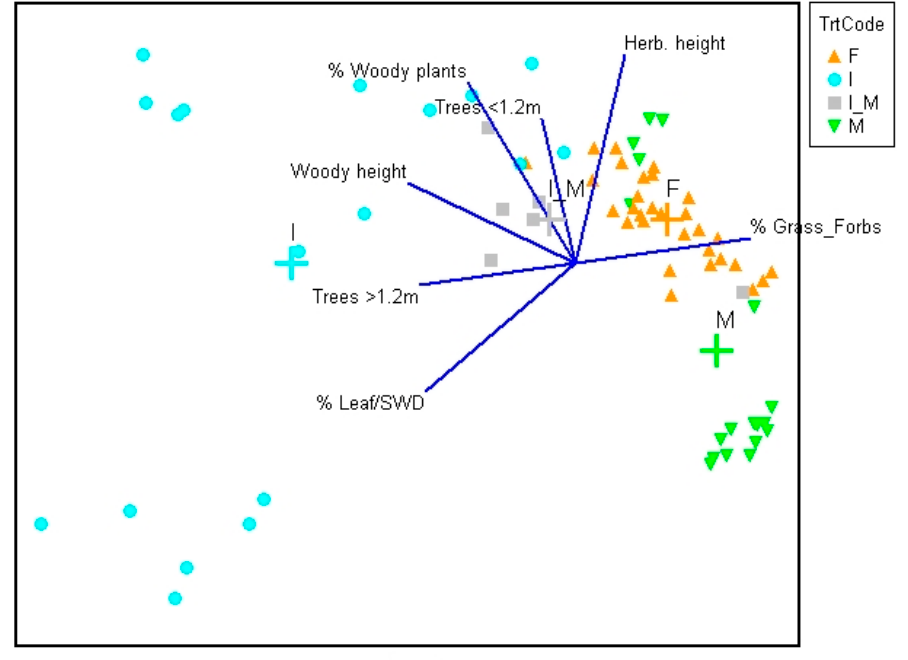
Figure 3. Principal components analysis (PCA) ordination of vegetation characteristics averaged within transects, or in the case of trees, counted along transects. Small symbols represent transects, crosses indicate group centroids, and lines indicate PCA loadings of each variable. Blue circles in lower left were from site O5S, and green triangles in lower right from sites O20 and G11NW. Treatment abbreviations as in Table 1. Variable abbreviations as in Supplementary Table S1. Table 2. Standardized relative importance of each variable to the first two principal component axes. Eigenvectors were scaled to standard deviations (also called “weights”). Variables ordered by descending absolute weights along first axis.